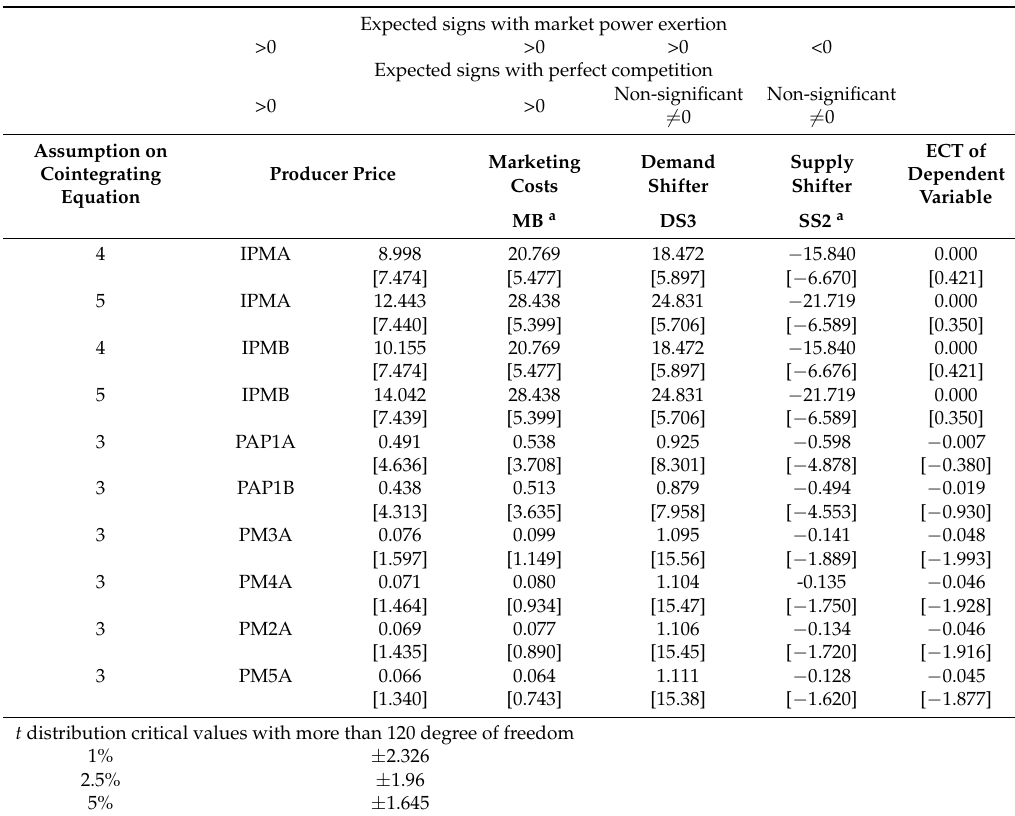
Table 4. Dataset AB (January 1996–October 2008) ECM cointegrating vectors parameters [ t values] normalized with respect to retail price (149 observations. 4 lags in variables). Expected signs with market power exertion >0 >0 >0 <0 Expected signs with perfect competition Non-significant >0 >0 (cid:54) = 0 Assumption on